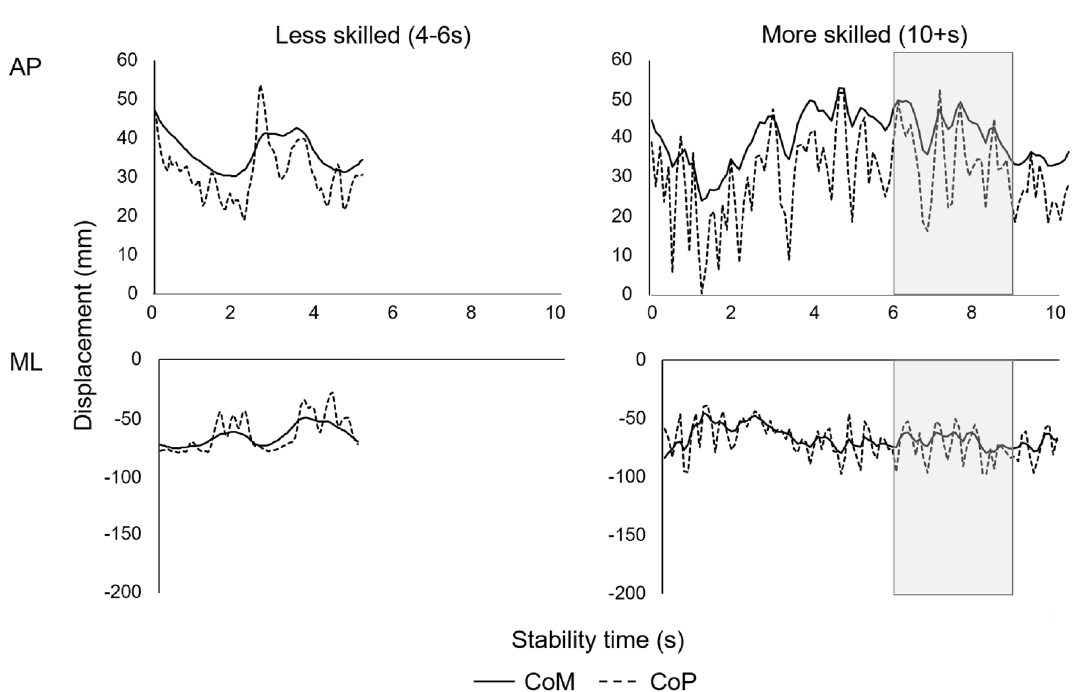
Figure 2. CoM and CoP AP and ML displacement for example trials from a less skilled and a more skilled gymnast. Shaded periods indicate the data phases used for more skilled balance phase analysis (6-9